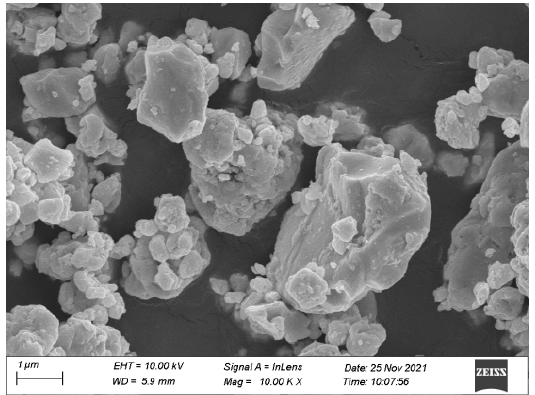
Figure 23. XPS spectra of O 2 − , Ag + , P 5+ , Gd 3+ , Bi 3+ and Ta 5+ from the Ag 3 PO 4 /Gd 2 BiTaO 7 heterojunction photocatalyst after the reaction of photocatalytic degradation of bisphenol A.